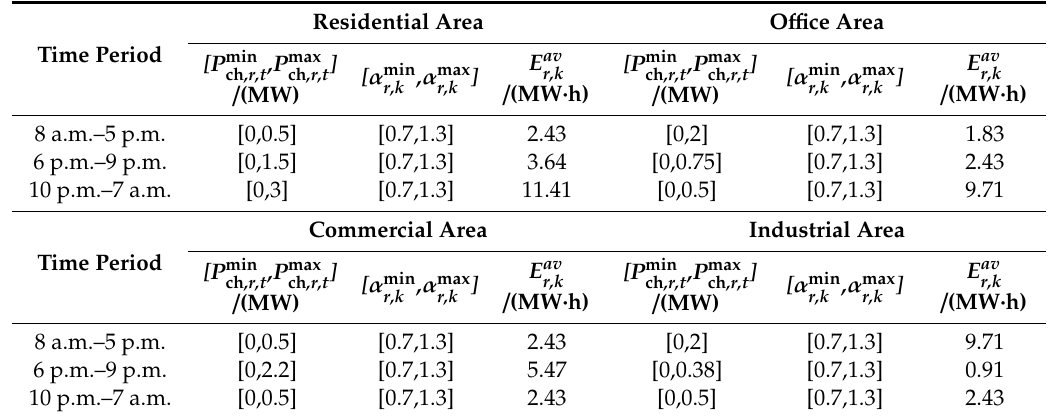
Table A3. Parameters of EVs.